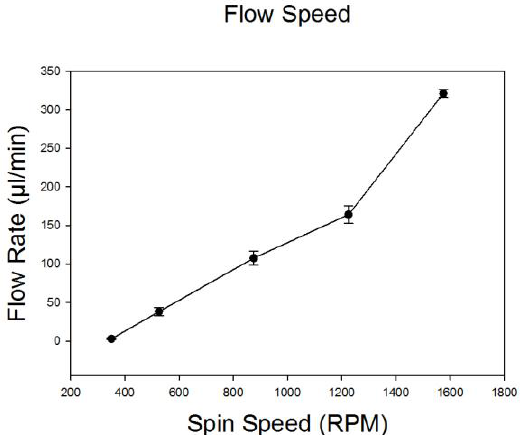
Figure 2. Characterization of fluid flow rates (1X PBS and Ficoll–Paque) at 400, 550, 900, 1250 and 1600 rpm ( n = 3). The ratio of PBS to Ficoll was maintained constant at 1:4 by adjusting the resistances of the tubing.